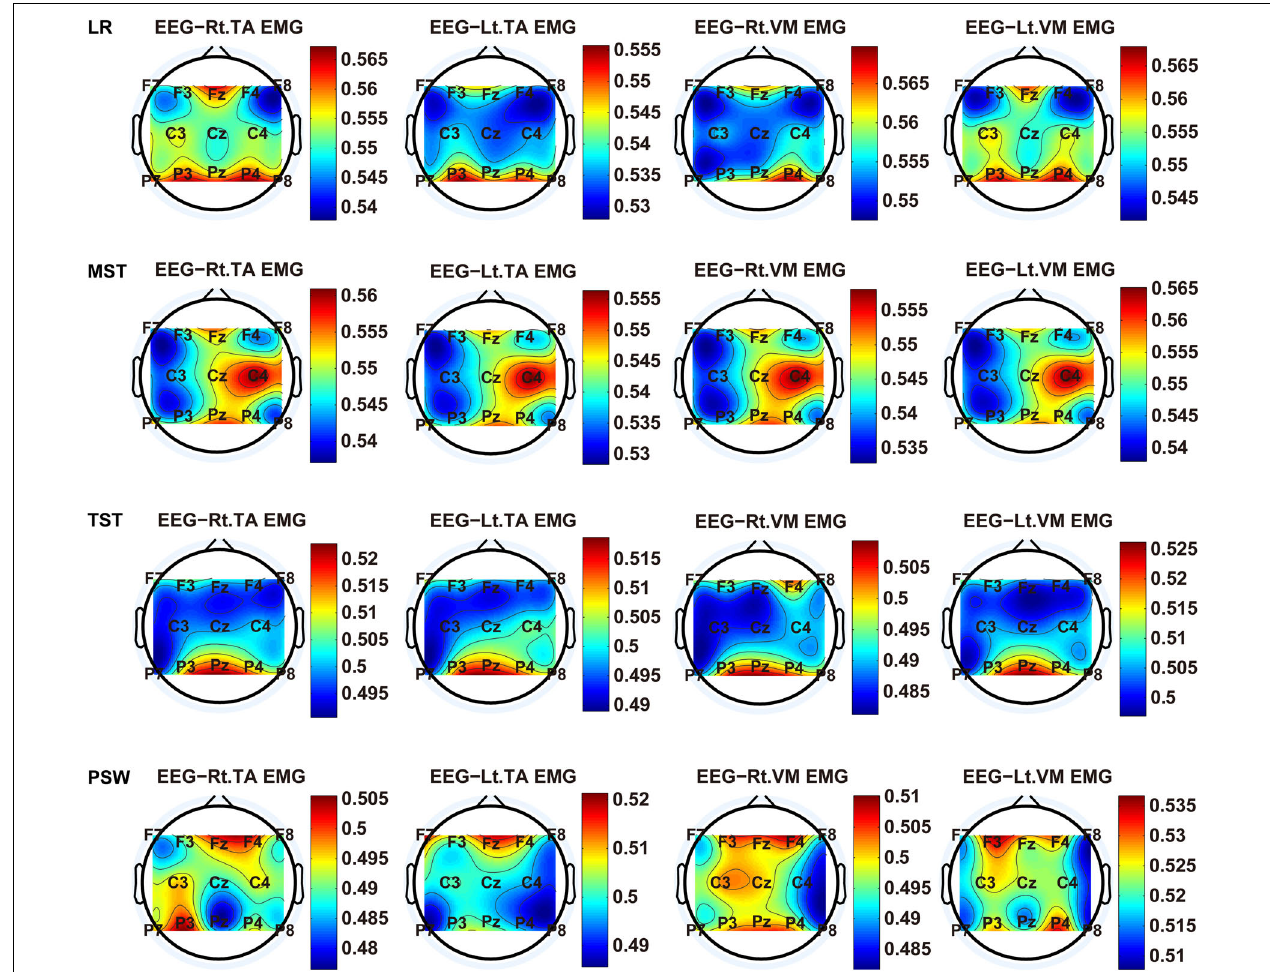
FIGURE 5 | The TFCMI topography between EEG (beta band) and sEMG (TA and VM) of the stance phase (LR, MST, TST, and PSW).